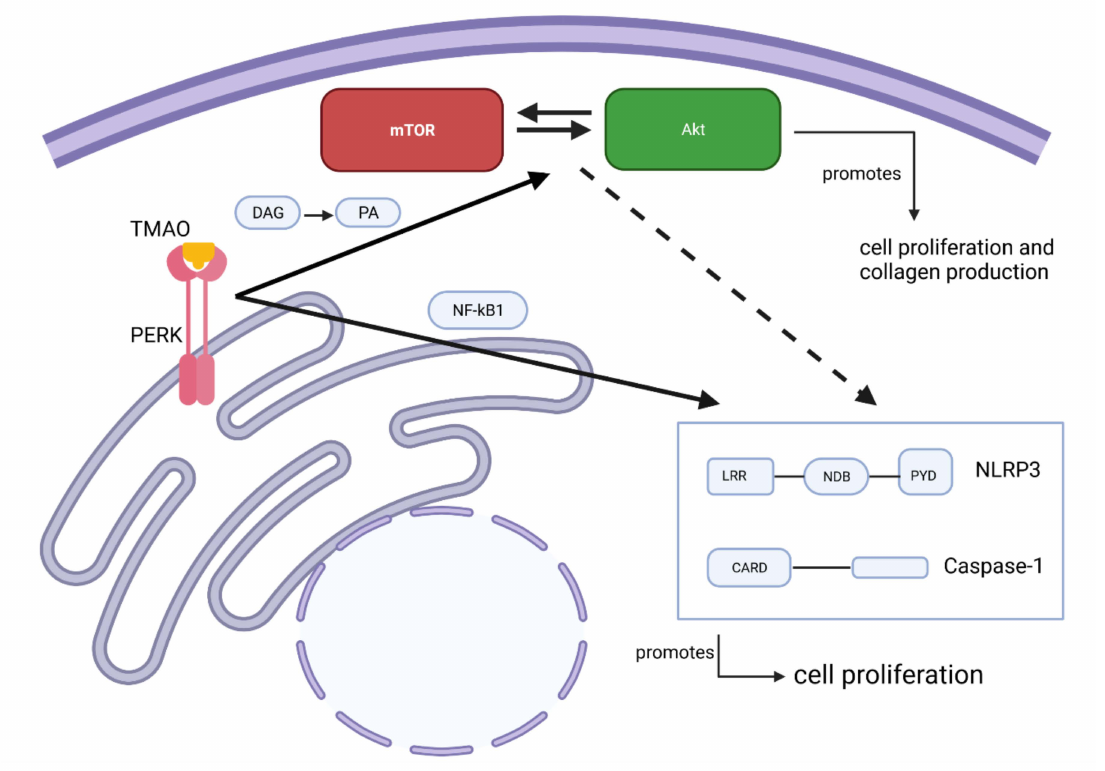
Figure 7. Proposed molecular mechanism of the effect of TMAO on renal fibroblasts. PERK is an intracellular TMAO receptor. This could be true in renal fibroblasts, as shown in the current study. Phosphorylated PERK is proposed to trigger the mTOR complex formation via diacylglycerol (DAG) conversion to phosphatidic acid (PA). mTOR can either activate or be activated by Akt. The Akt/mTOR pathway then promotes cell proliferation and collagen production. Alternatively, the same pathway can, as previously shown, regulate NLRP3 and caspase-1 and, indirectly, affect cell proliferation. Activated PERK can directly affect NLRP3 via NF- κ B